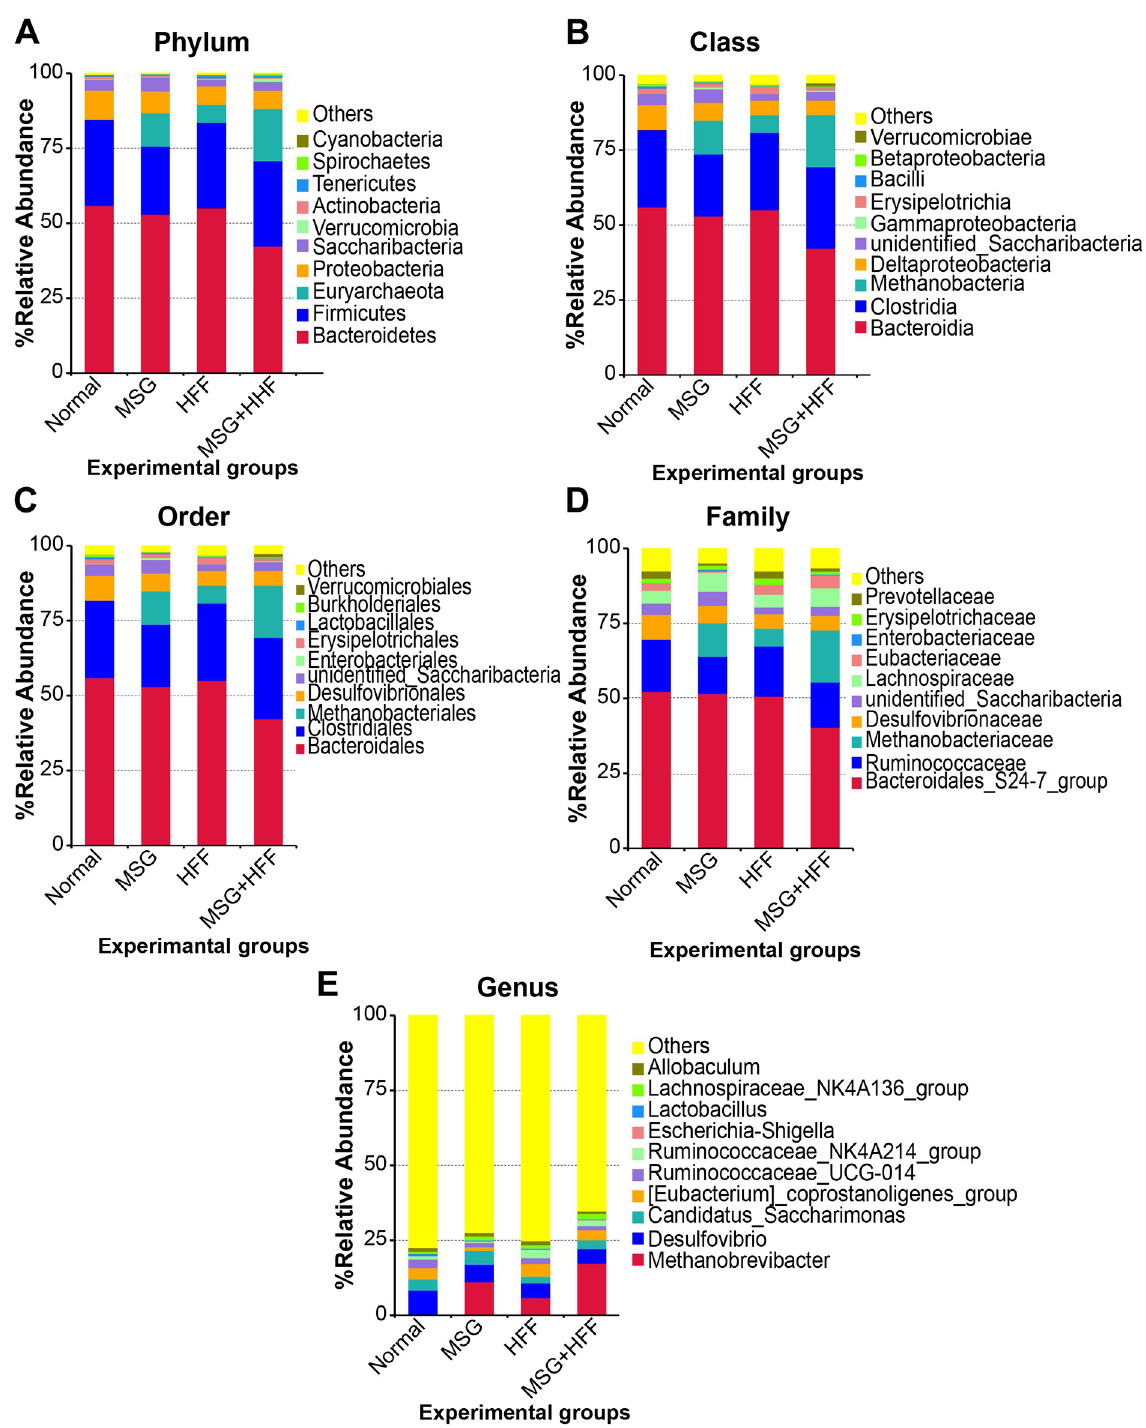
Fig 2. Fecal microbial composition in hamsters at different taxonomic levels. The columns represent a normal group (n = 10), monosodium glutamate-treated group (MSG) (n = 10), high-fat and high-fructose diet-treated (HFF) (n = 10) and MSG and HFF diet-treated (MSG+HFF) (n =